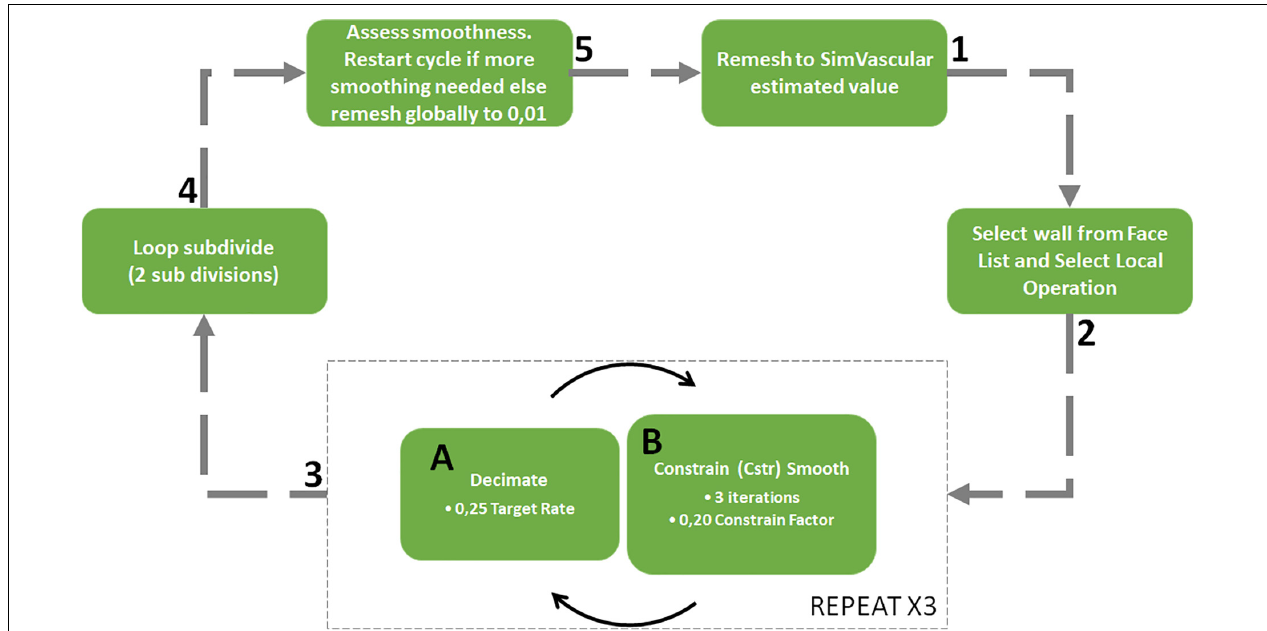
FIGURE 2 | Surface meshing and corner smoothing cycle starting at 1 and following the arrows with sub cycle at phase 3.